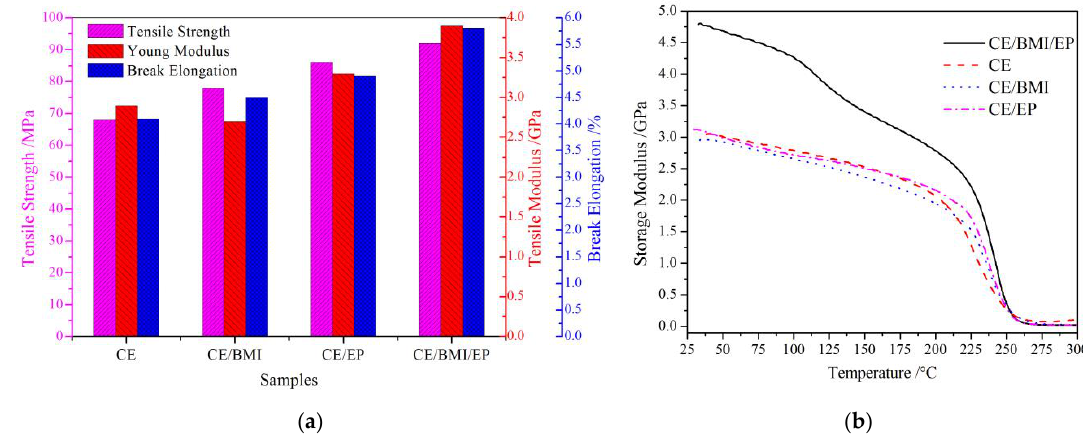
Figure 3. ( a ) The tensile strength, Young modulus, and break elongation of pure CE and CE-based composites; ( b ) DMA temperature spectra of pure CE and CE/EP, CE/BMI, and CE/BMI/EP composites after curing.